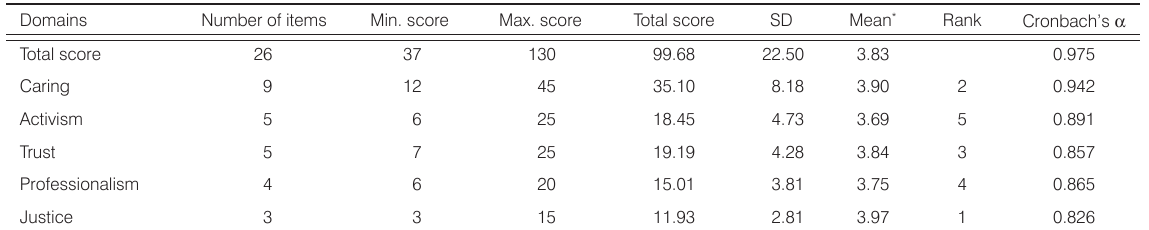
Table 2. Descriptive statistics for NPVS-R and its domains